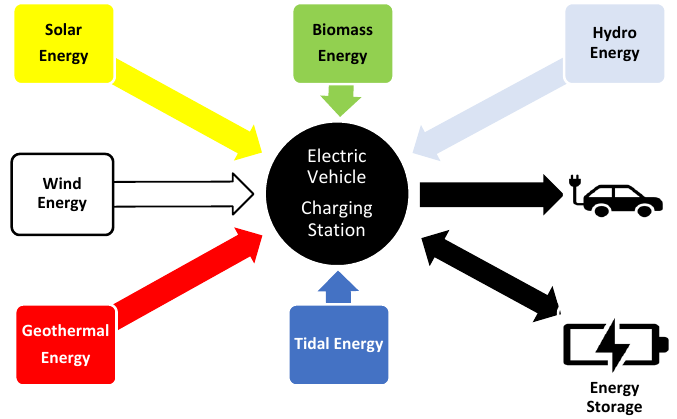
Figure 1. RE-based standalone plugin electric vehicle charging station .